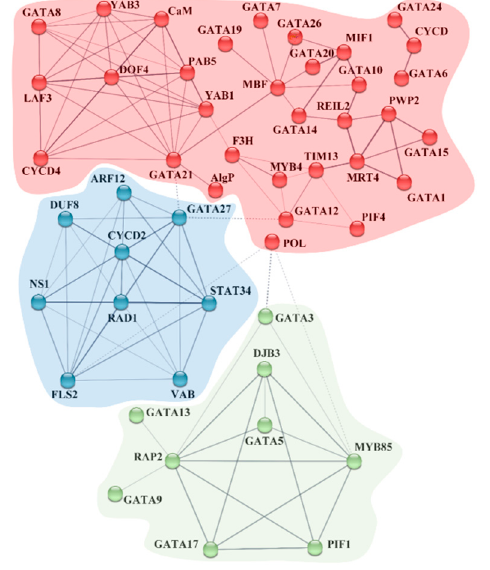
Figure 5. Interaction network of GATA and related genes. Line thickness indicates the strength of data support. The associations were inferred from the evidence from the STRING database—known interactions, predicted interactions, and others.